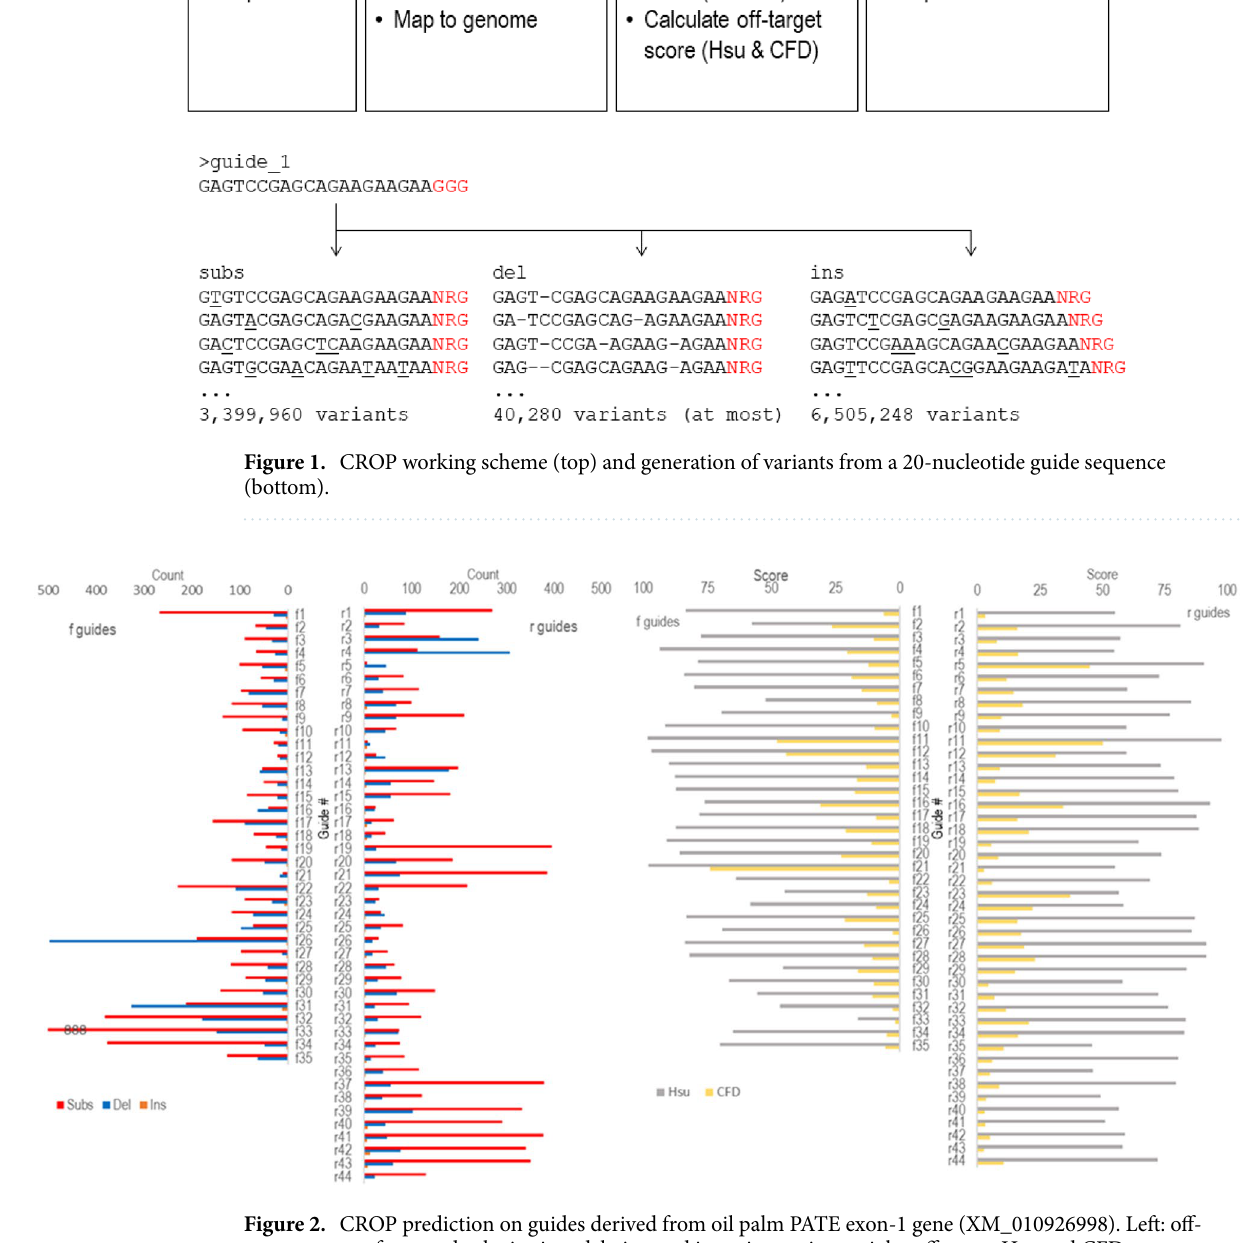
Figure 2. CROP prediction on guides derived from oil palm PATE exon-1 gene (XM_010926998). Left: off- target counts of mapped substitution, deletion and insertion variants; right: off-target Hsu and CFD scores derived from mapped substitution variants. Higher score translates to lower off-target